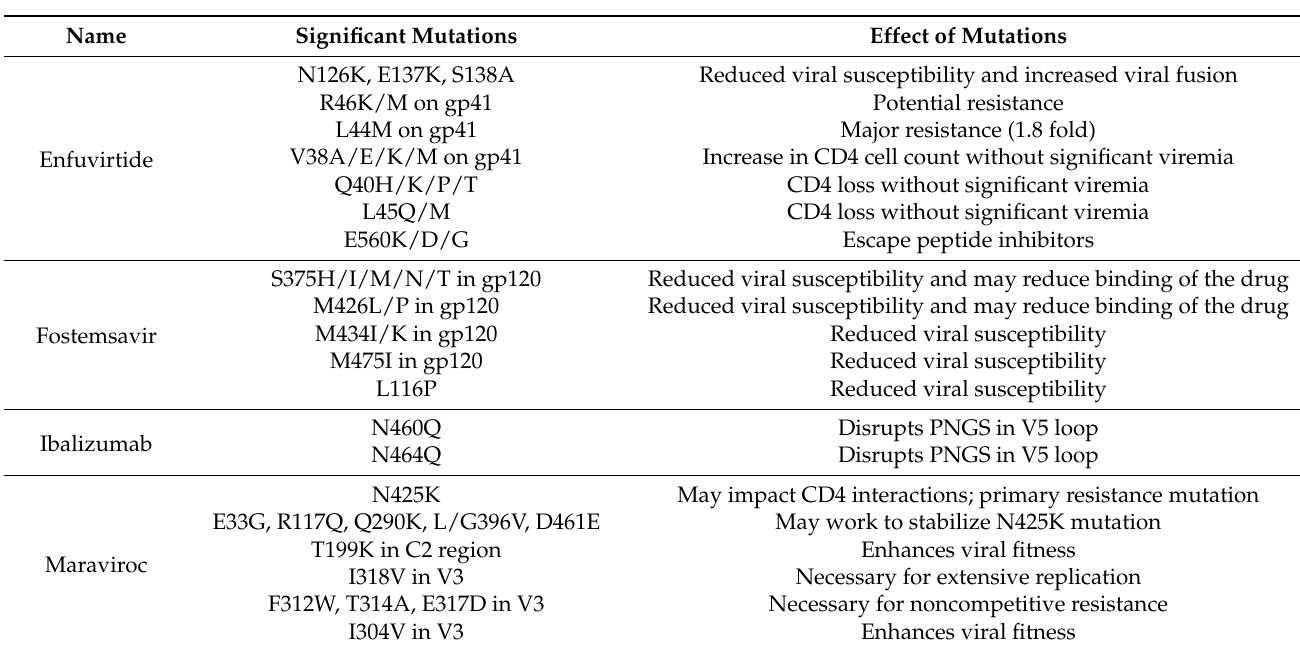
Table 2. Mutation patterns that result from attachment and entry inhibitor